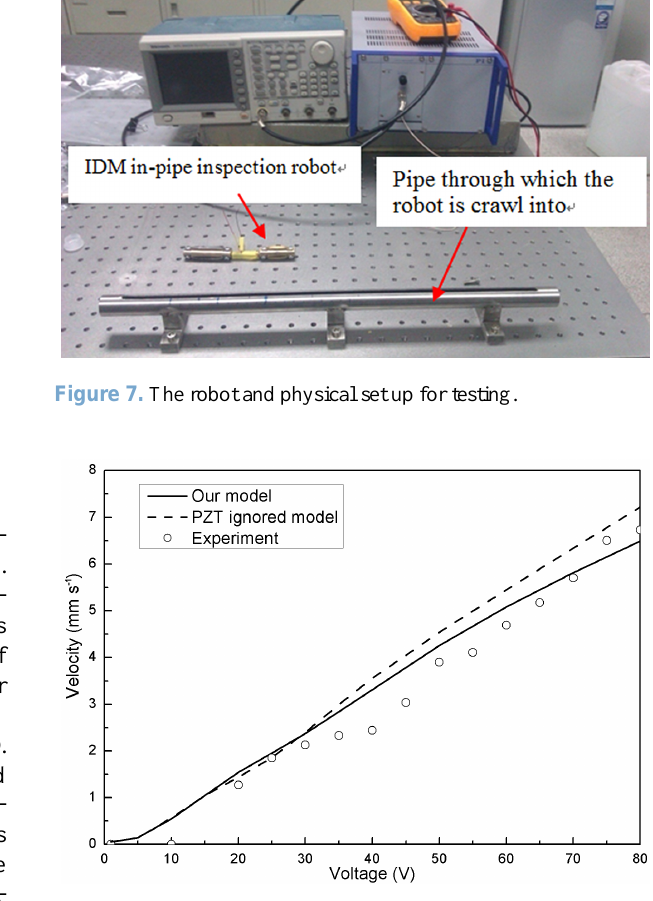
Figure 8. Velocity vs.